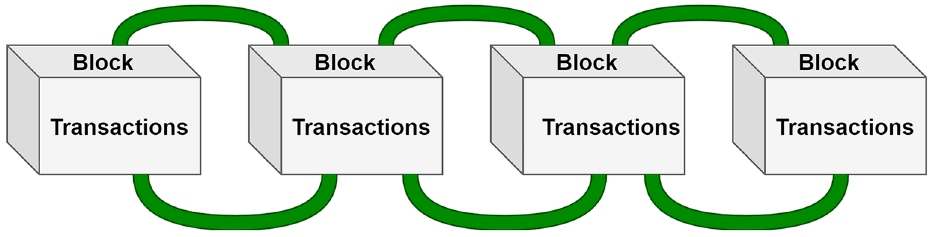
Figure 1. Multiple blocks connected together to form a blockchain